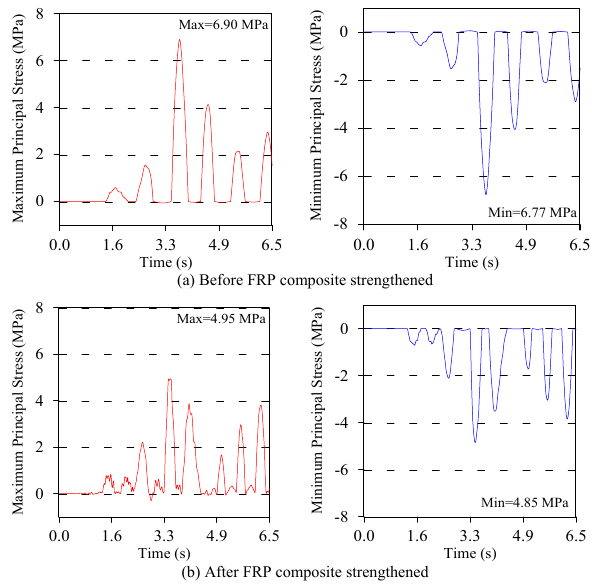
Figure 11 The time histories of maximum and minimum principal stresses of İ skenderpa ş a historical minaret before and after FRP composite strengthened Fig. 11. The time histories of maximum and minimum principal stresses of the ˙Iskenderpas¸a historical minaret before and after FRP composite